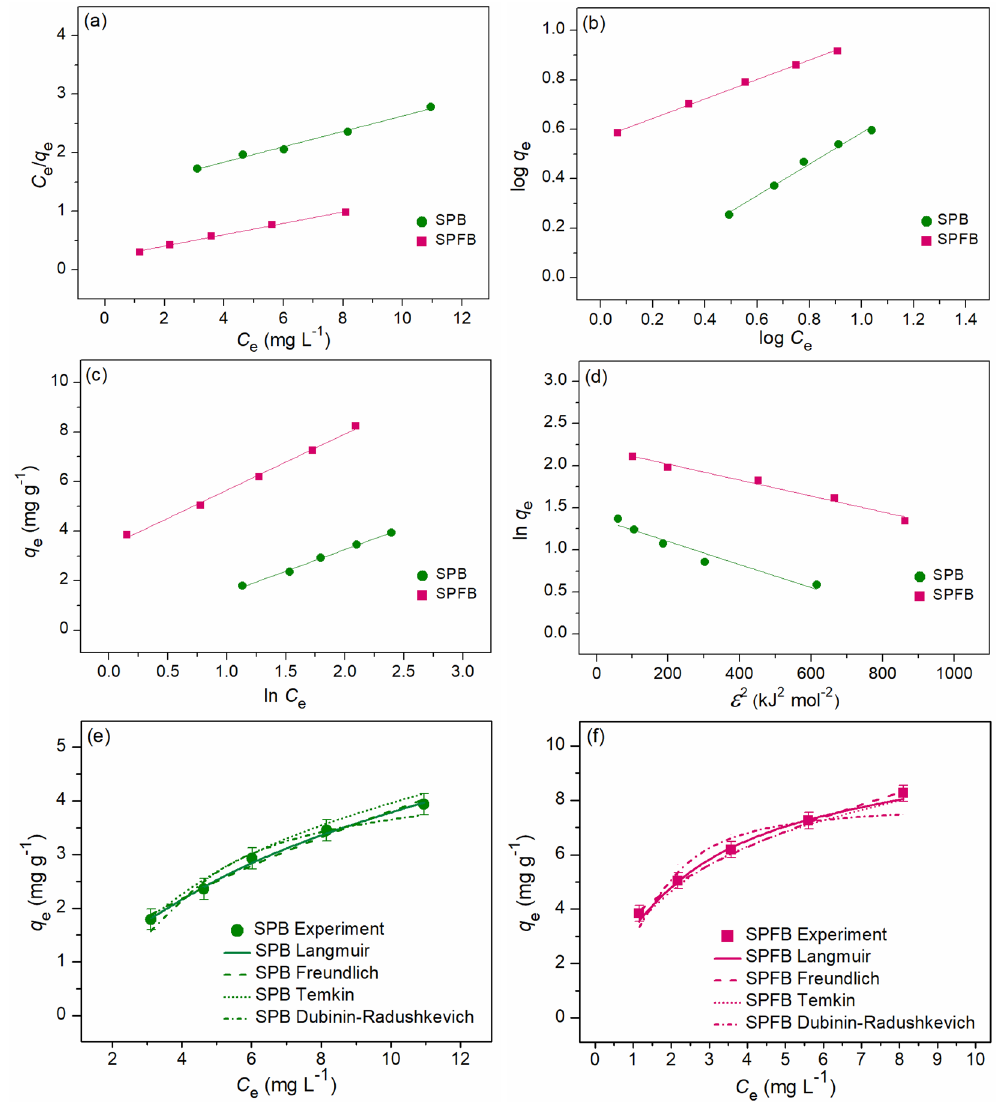
Figure 7. Graphs of ( a ) linear Langmuir, ( b ) linear Freundlich, ( c ) linear Temkin, ( d ) linear Dubinin– Radushkevich, and ( e , f ) nonlinear adsorption isotherms of sawdust beads (SPB), and sawdust powder doped iron (III) oxide-hydroxide beads (SPFB) for RB4 dye